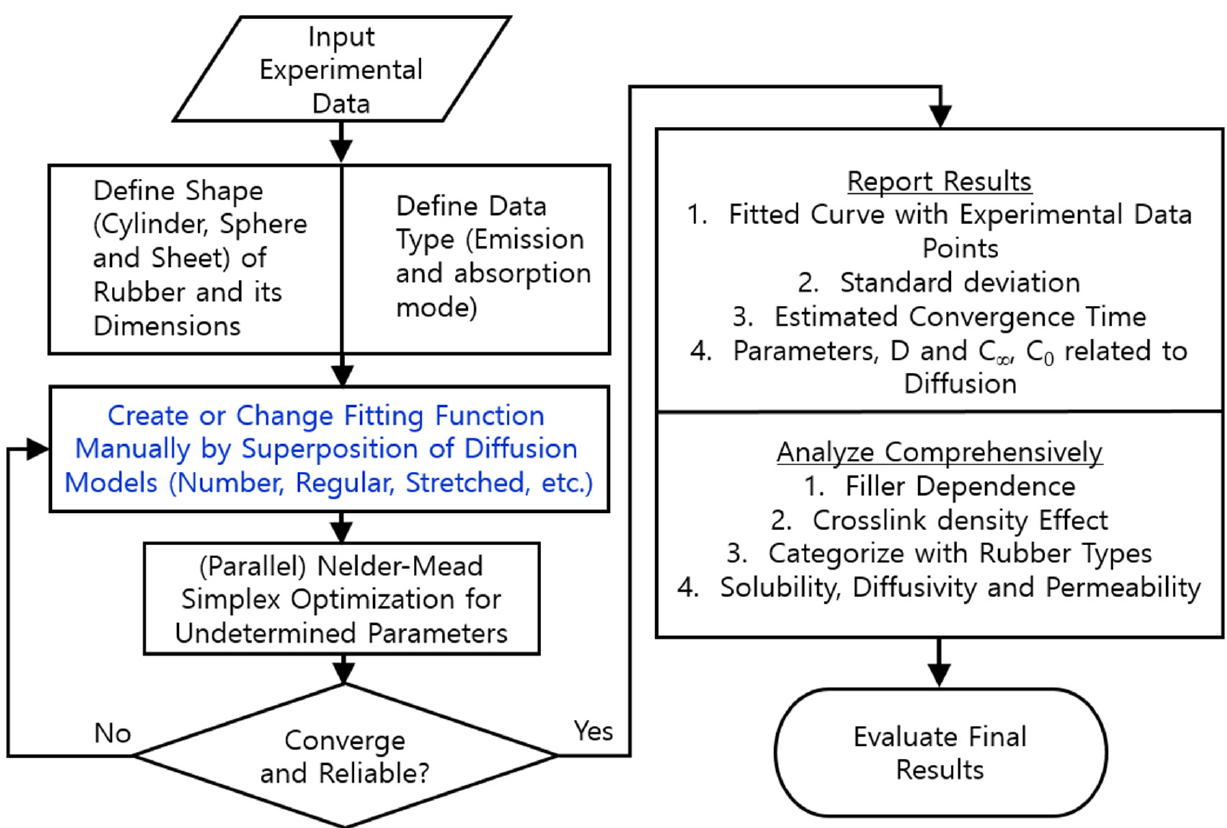
Figure 2. Flowchart for analyzing the diffusion data set for various types of rubbers via the Nelder– Mead simplex nonlinear optimization